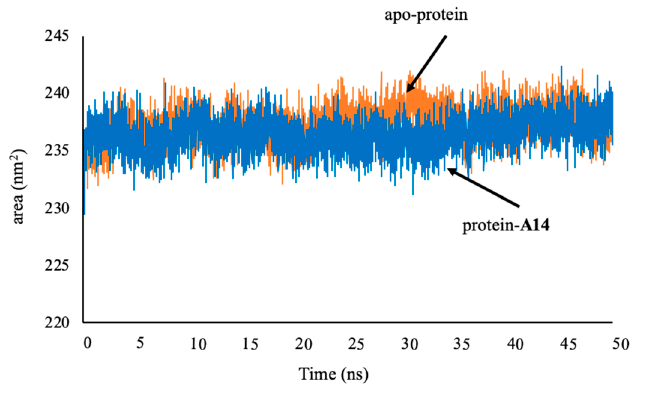
Figure 13. Total solvent-accessible surface area (SASA) of protein 1LPB in apo-protein and protein– A14 complex.